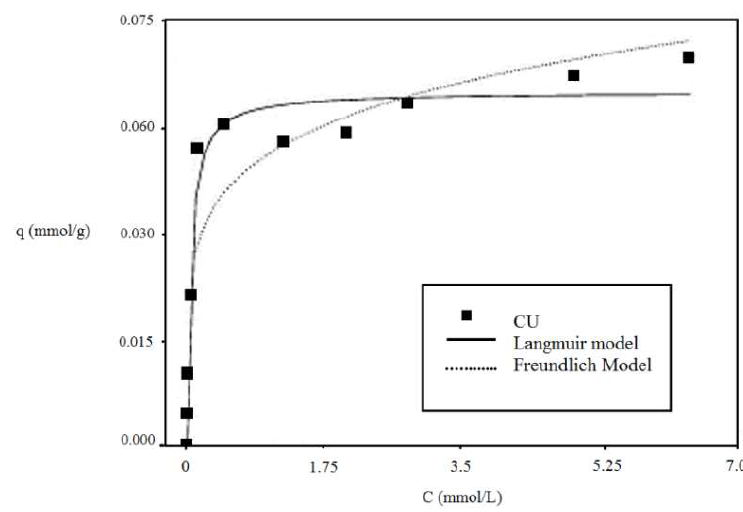
Figure 1. Demonstration of Cu adsorption mechanism by Langmuir and Freundlich isotherms